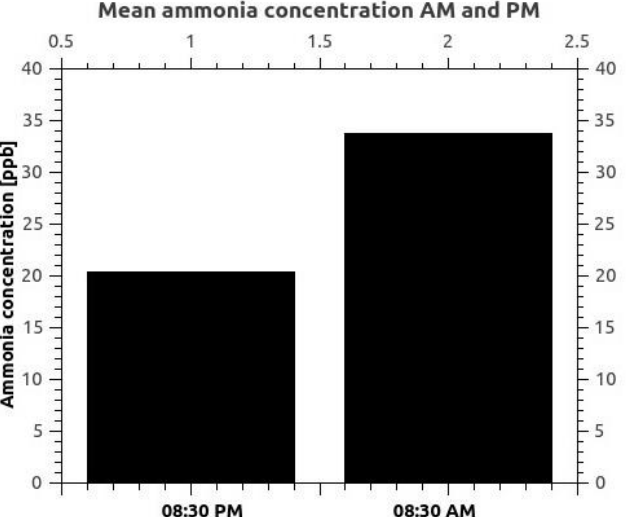
Figure 6. Diurnal variation of the average ammonia concentrations in the interval 08:30–11:30 AM and 07:30–08:30 PM in the three points P1, P2, and P3 over the entire monitoring period March–August 2021.